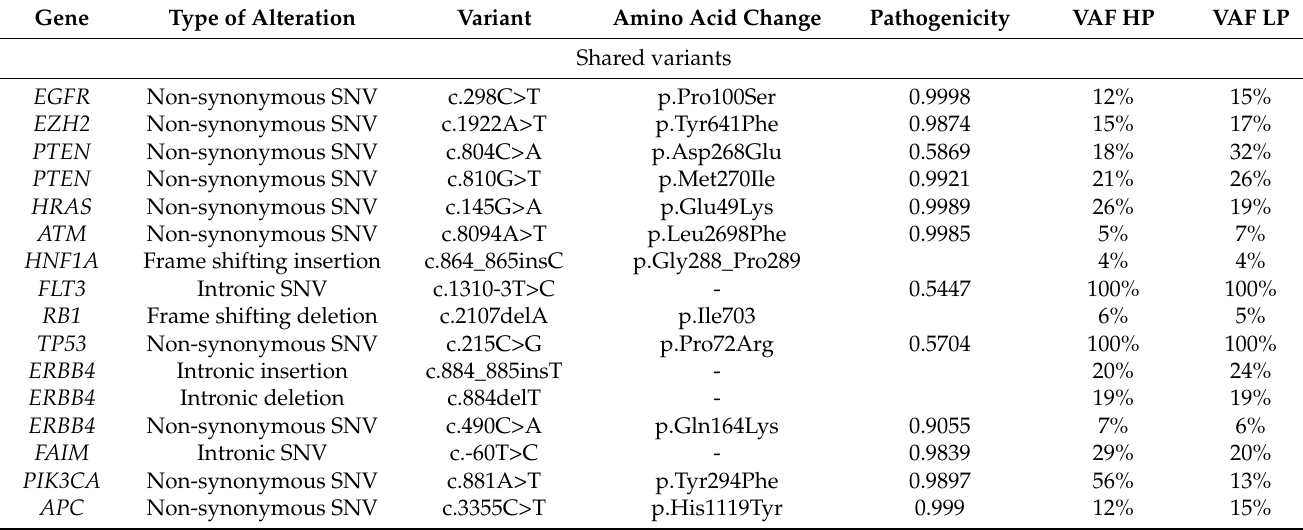
Table 4. Molecular characteristics of variants detected in tumor tissue of Patient